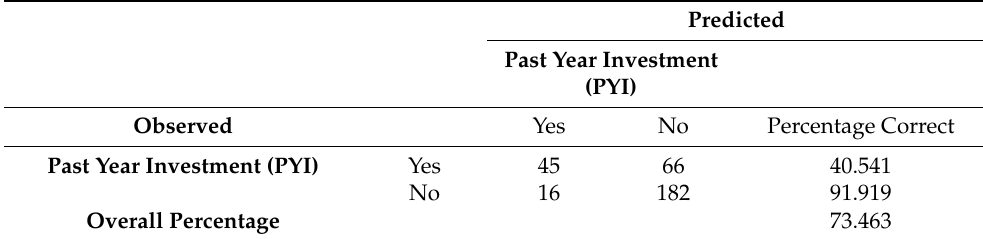
Table 7. Predicted